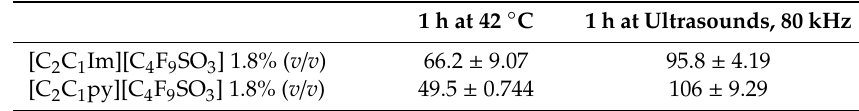
Mean values calculated from two independent assays and their standard deviations.